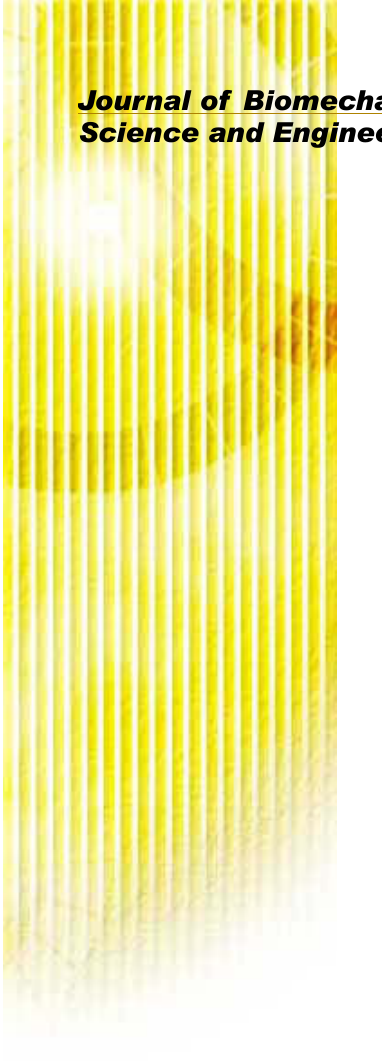
Table 2. NRMSE of the simulated trajectories from the identified models